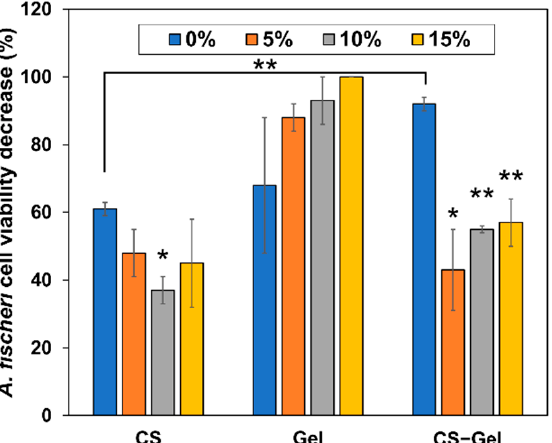
Figure 8. The decrease in A. fischeri cell viability upon 5-minute exposure to chitosan (CS), gelatin (Gel), and chitosan–gelatin (CS-Gel) films prepared by cross-linking with 0%, 5%, 10%, or 15% addition of dialdehyde starch nanocrystals (NDASs). Statistical significance is indicated with asterisks: * p < 0.05, ** p < 0.01.